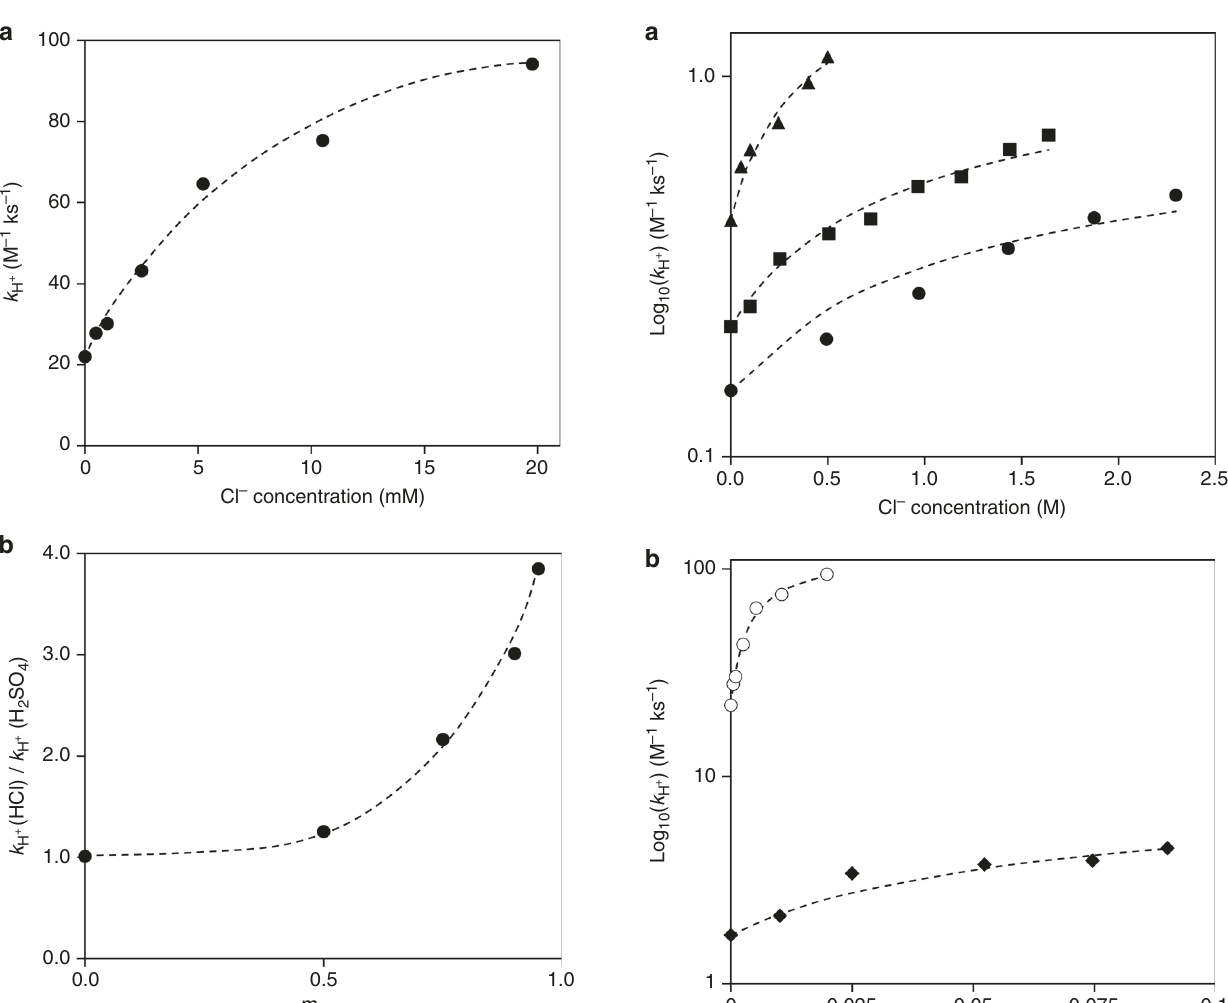
stants for the formation of the chloride transition state (i.e., K Cl ) for each GVL/H 2 O solvent system. This plot shows that the